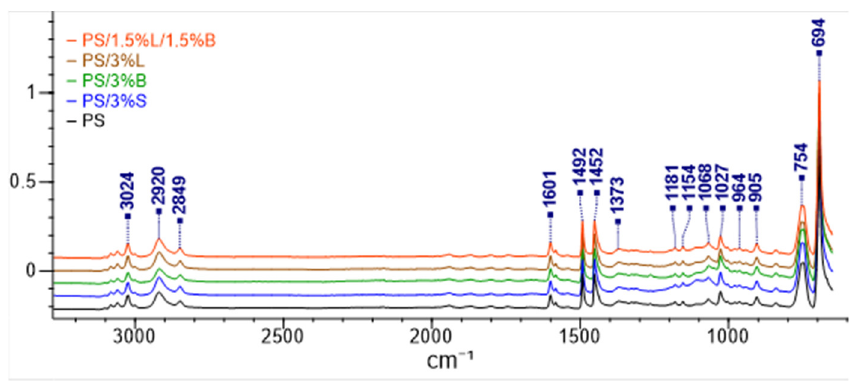
Figure 10. FT-IR spectra recorded for the